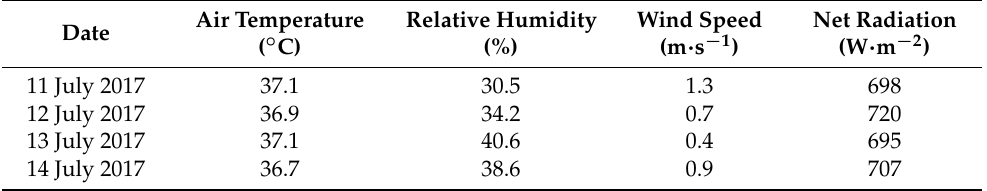
Table 1. The main meteorological factors (local time